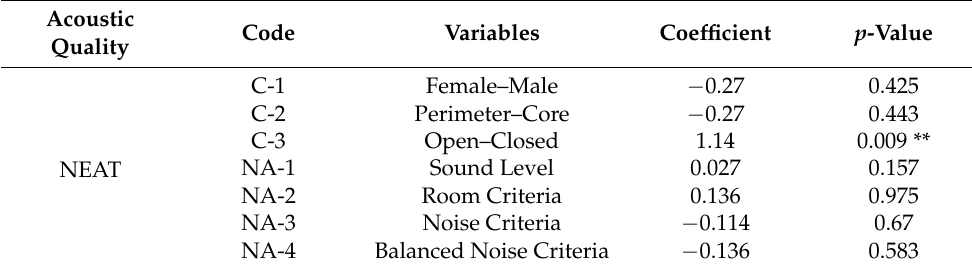
Table 7. Correlation analysis between NEAT acoustic quality measurements and the acoustic satisfac- tion with background noise ( n =